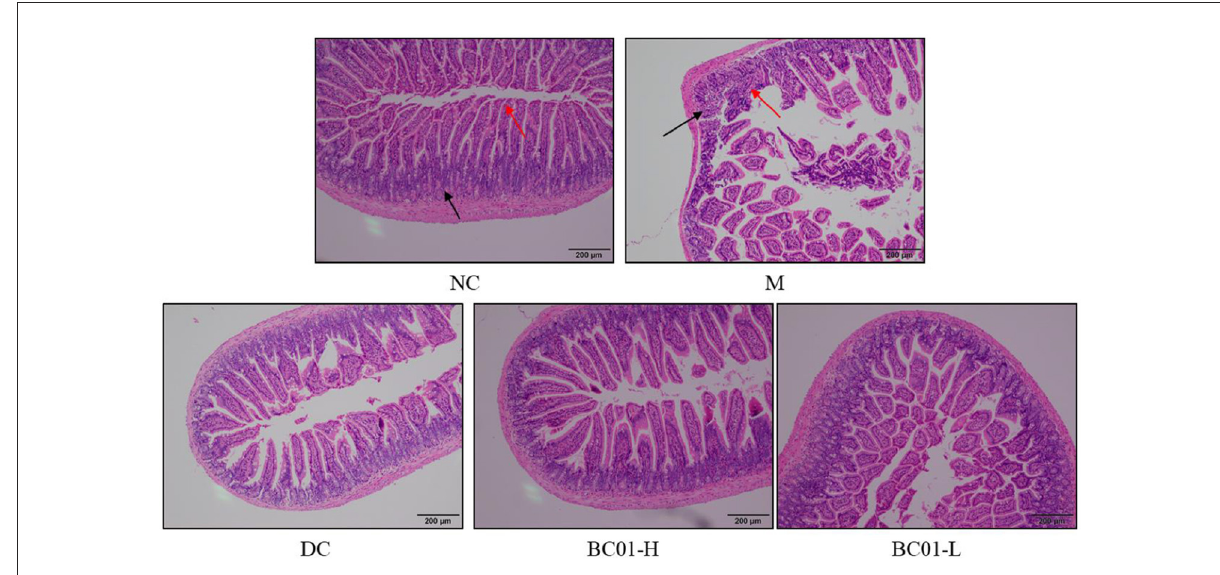
FIGURE4 Histology of the small intestine tissue sections stained with H&E stain. NC, normal group; M, constipation model group; DC, bisacodyl control group; BC01-H, B. coagulans BC01 high-dose group; BC01-L, B. coagulans BC01 low-dose